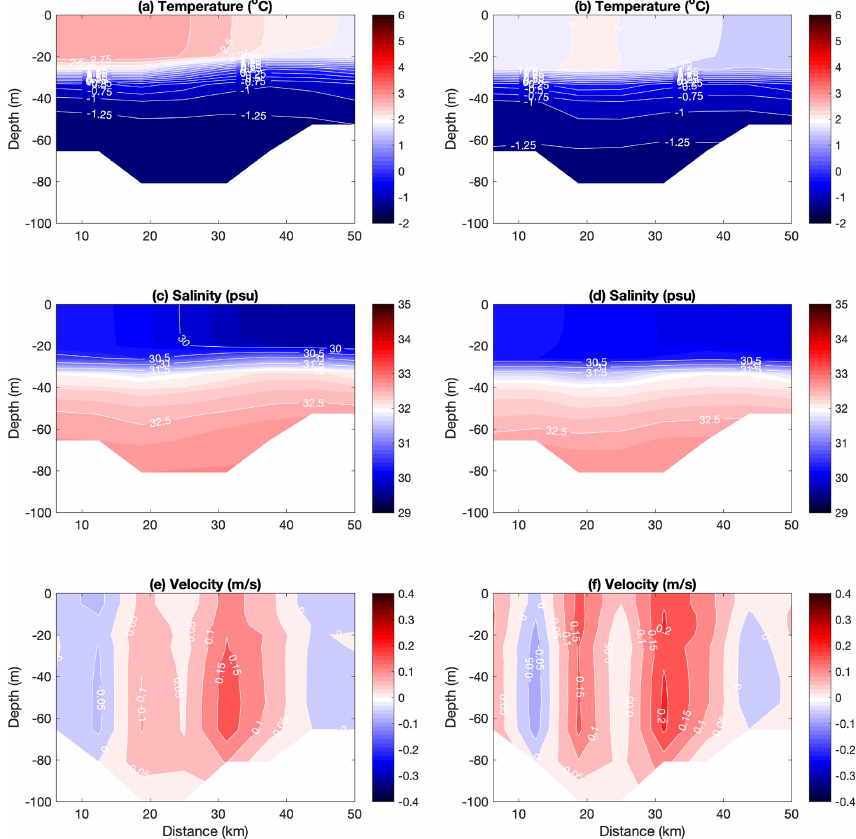
Figure 11. Modelled vertical sections from the 9km simulation across section 3 on 27 August 2014 (a, c, e) and 11 September 2014 (b, d, f)